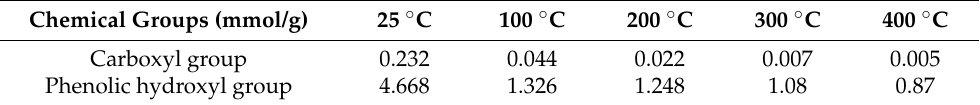
Table 6. Effects of heating temperature on content of chemical groups in humic acid. Chemical Groups